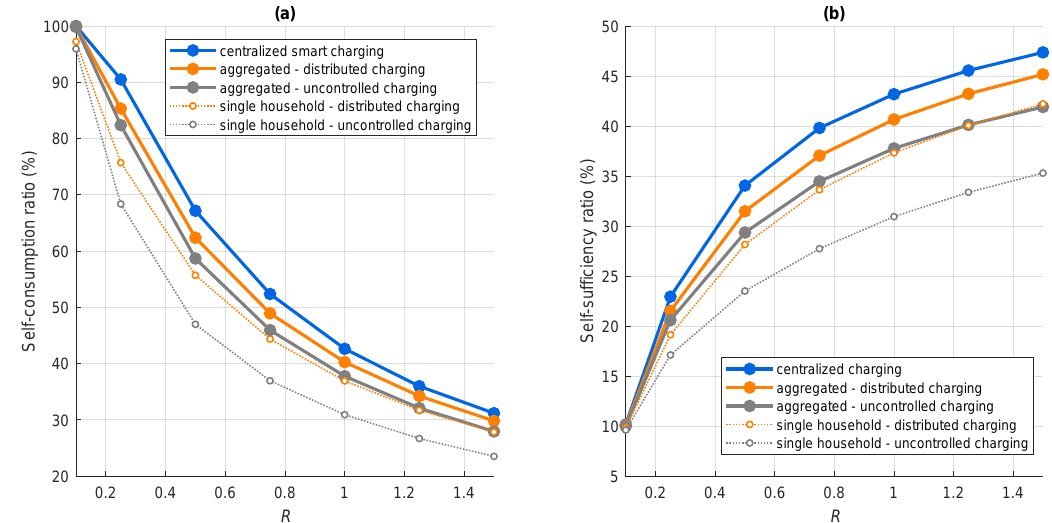
Figure 8. ( a ) Self-consumption ( SC ) and ( b ) self-sufficiency ( SS ) compared with production-to- consumption ratio R for a single household and an aggregation of 100 households with the uncontrolled charging scheme and the distributed and centralized smart charging